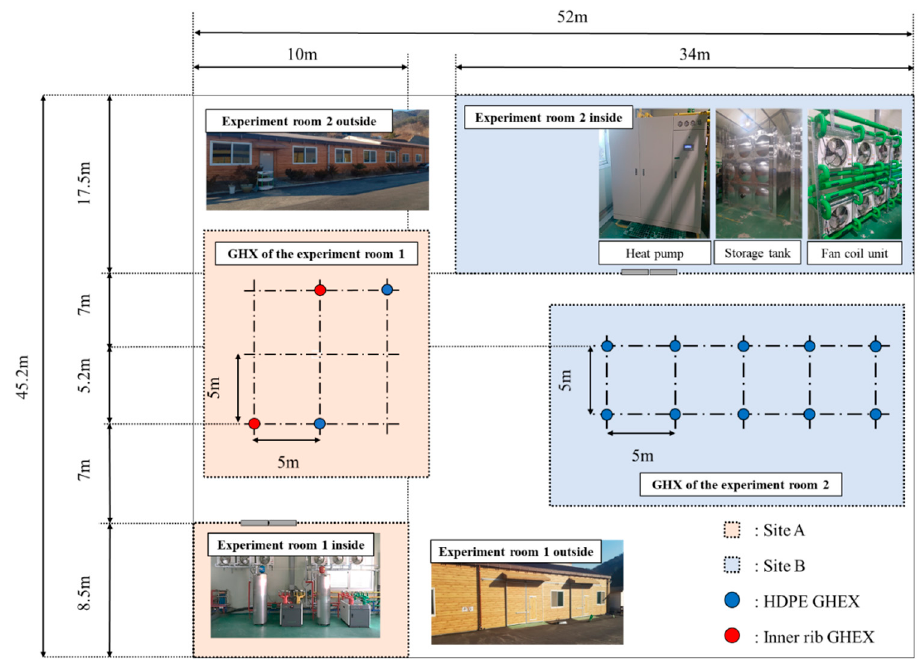
Figure 1. Placement of ground source heat pump (GSHP) boreholes.